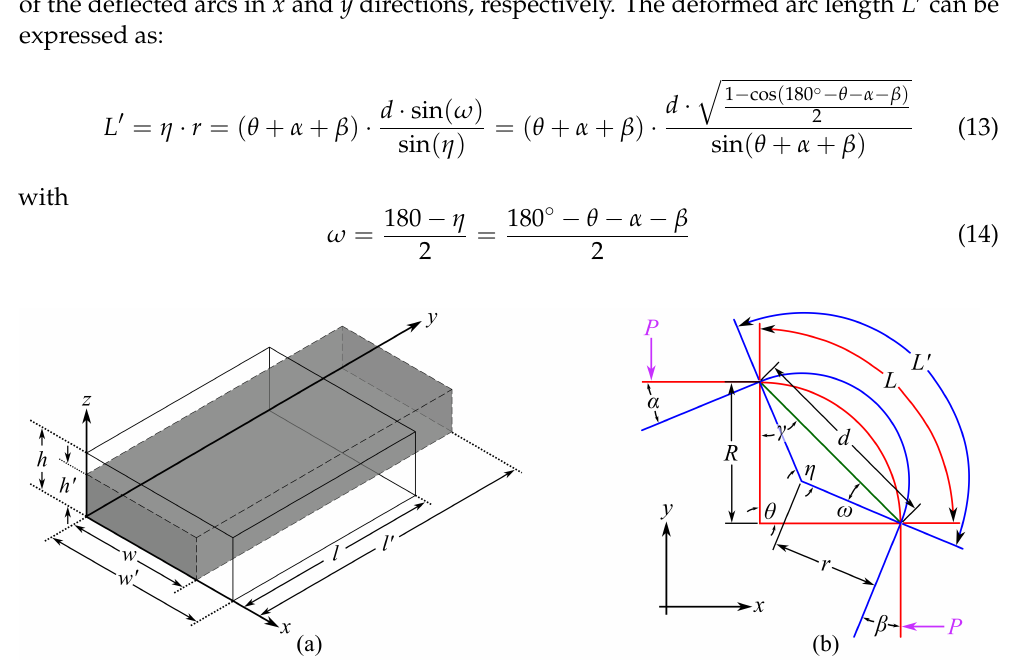
Figure 2. ( a ) Small cuboid unit of the mesh element; ( b ) deformation of an arc under